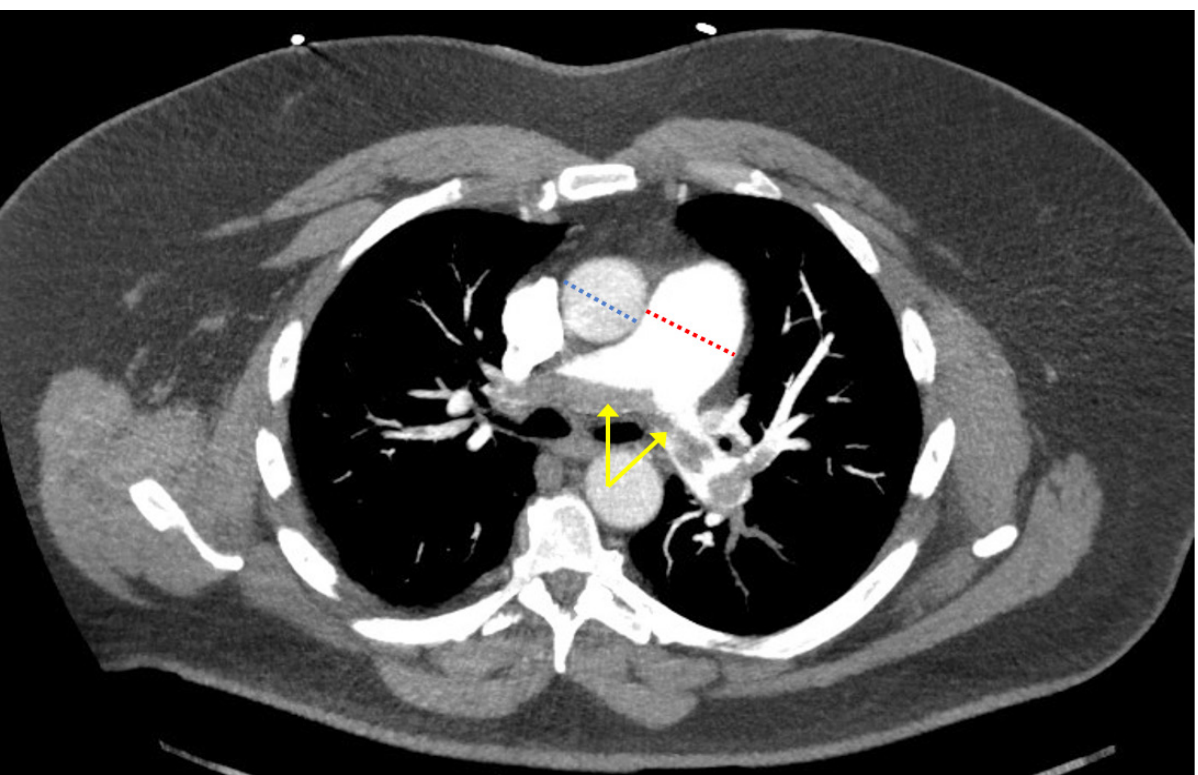
Image 1. Computed tomography pulmonary angiogram demonstrating a saddle embolism at the main pulmonary artery bifurcation extending into right and left pulmonary arteries (yellow arrows). Also visible is an enlarged main pulmonary artery diameter (red dashed line) relative to the ascending aorta (blue dashed line) indicating right-sided heart strain with pulmonary